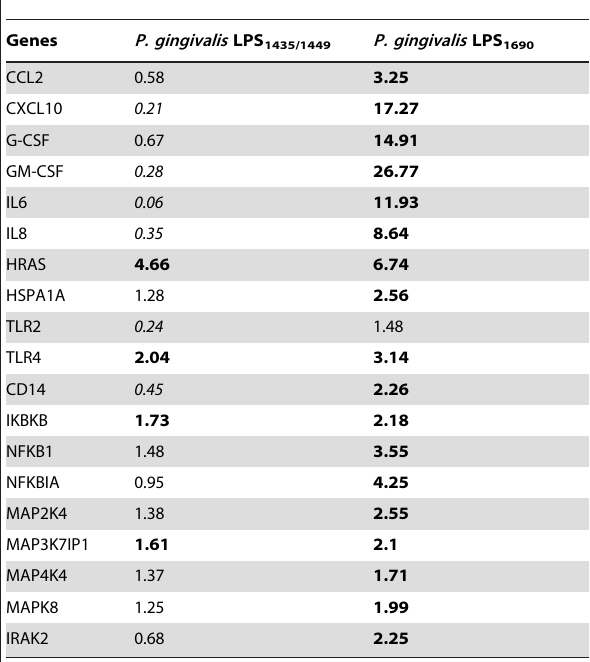
Table 1. List of genes upregulated (fold changes $ 1.5; highlighted in bold) and downregulated (fold changes # 0.5; highlighted in italics) by P. gingivalis LPS 1435/1449 and P. gingivalis LPS 1690